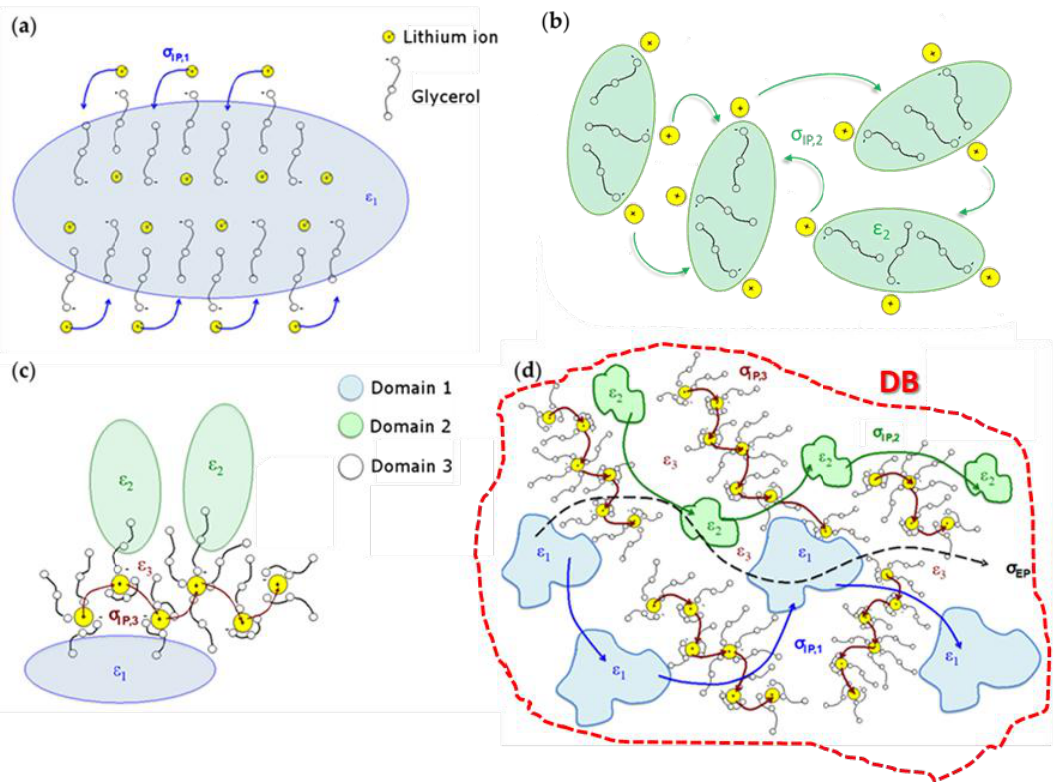
Figure 14. Proposed conduction mechanism for ( a ) σ IP,1 , ( b ) σ IP,2 , and ( c ) σ IP,3 ; ( d ) overall proposed conduction mechanism. The delocalization body (DB) is highlighted with a red dotted line.